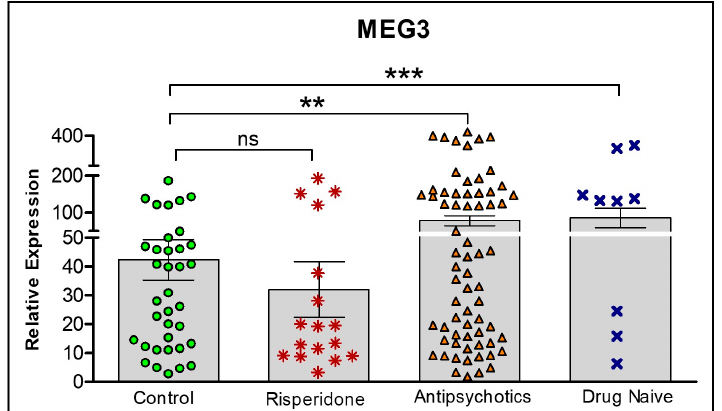
Figure 7. Comparison of lncRNA MEG3 expression levels from four treatment conditions : controls, risperidone only, currently on any other antipsychotic, and drug naïve. Statistical significance is determined by t -test (** p < 0.01; *** p < 0.001; ns, not significant). The figures represent Mean ± SEM for the relative expression of lncRNAs. SEM: Standard Error of Mean.